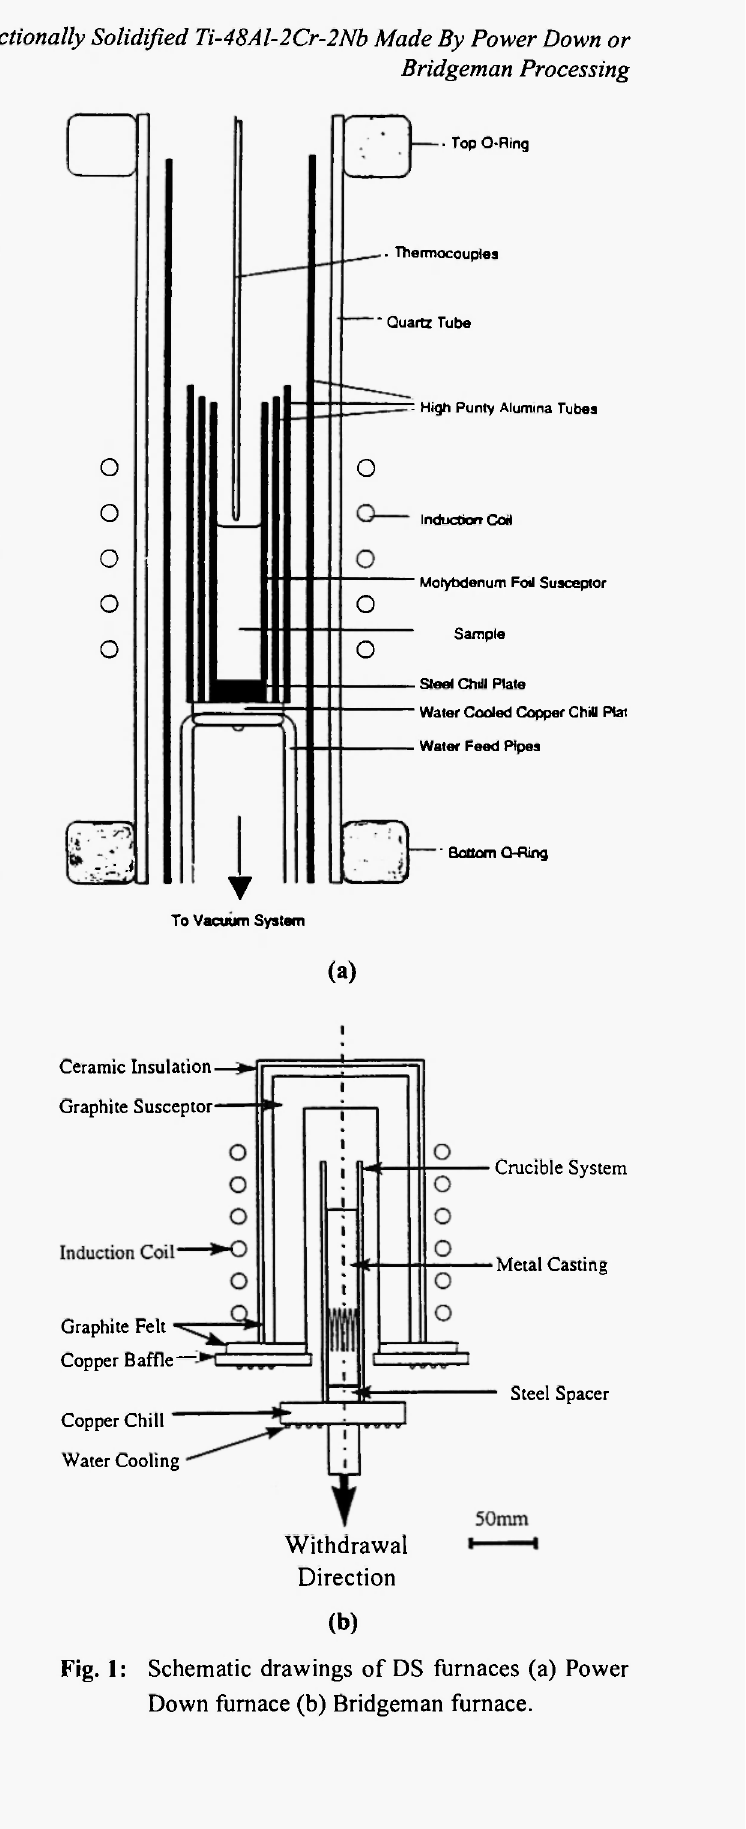
Fig. 1 : Schematic drawings of DS furnaces (a) Power Down furnace (b) Bridgeman